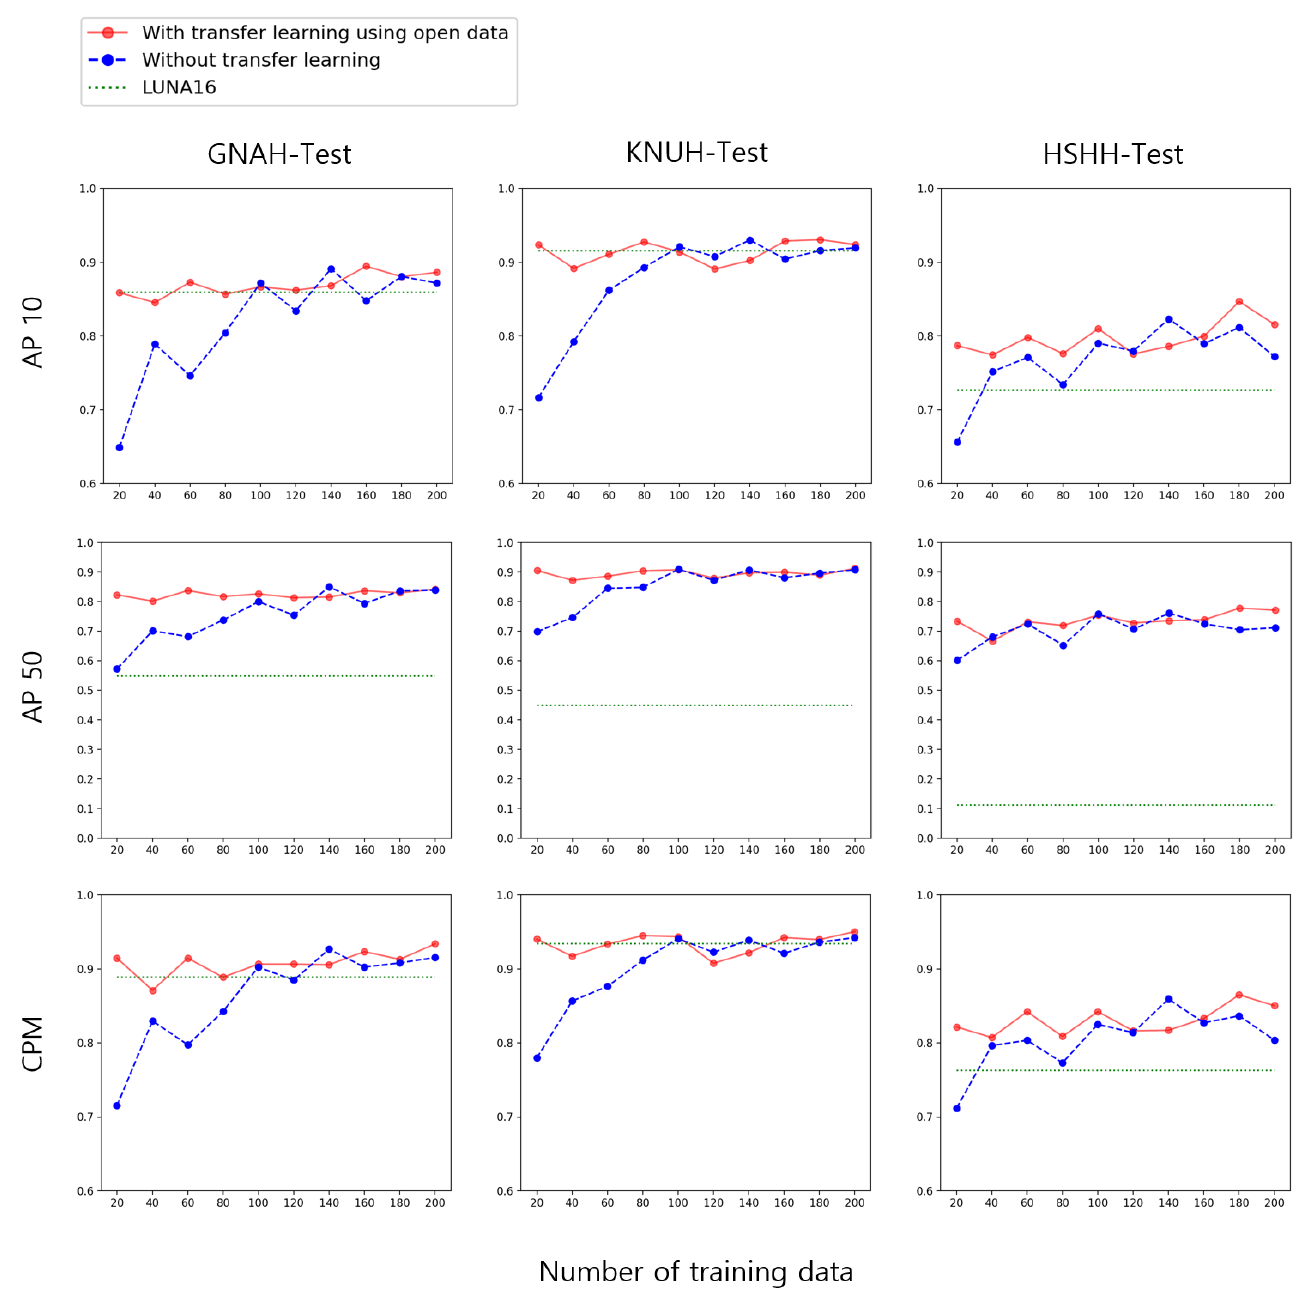
Figure A2. Experiment 3 — YOLOX.